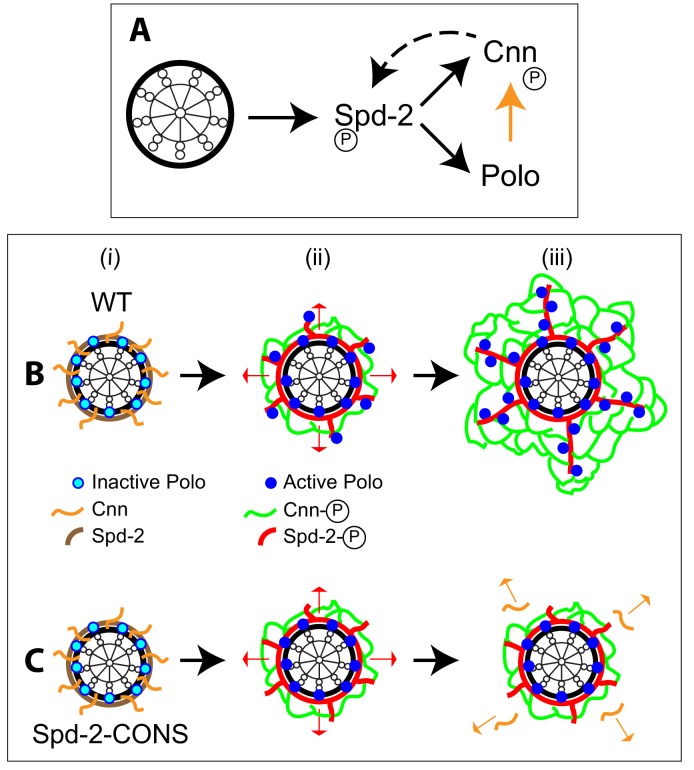
Spd-2, Polo and Cnn appear to form a positive feedback loop that drives the expansion of the mitotic PCM scaffold.(A) A schematic summary of the proposed positive feedback loop that drives the expansion of the mitotic PCM scaffold in Drosophila embryos. Solid black lines indicate recruitment, solid orange line indicates phosphorylation, dashed line indicates that Cnn does not recruit Spd-2, but rather helps to stabilise the Spd-2 scaffold that has been recruited to the mother centriole and is fluxing outwards. Polo may phosphorylate Spd-2 to create additional S-S/T(p) motifs that can then recruit more Polo, but this is not depicted here. This circuit is a classical positive feedback loop; ultimately, however, it relies on the mother centriole as a source of Spd-2, because Cnn itself cannot recruit more Spd-2 or Polo into the scaffold. (B,C) Schematics illustrate the process of centrosome maturation in a WT cell (B), and a cell in which Spd-2 cannot recruit Polo (C). During interphase (i), Spd-2, Polo and Cnn are all recruited to the mother centriole. Polo is inactive, Spd-2 and Cnn are not phosphorylated, so no scaffold forms. As cells prepare to enter mitosis (ii), Polo is activated, and the centrosomal Spd-2 and Cnn are phosphorylated, allowing them to initially assemble into a ‘mini-scaffold’ around the mother centriole. The phosphorylated Spd-2 scaffold then starts to flux away from the mother centriole (red arrows). In normal cells (B[iii]), the expanding Spd-2 scaffold recruits more Cnn and more Polo, allowing more Cnn scaffold to assemble. The Cnn scaffold cannot recruit more Spd-2 or Polo, but it stabilises the expanding Spd-2 scaffold; this allows the Spd-2 scaffold to accumulate around the mother centriole. This creates a positive feedback loop that drives an increasing rate of expansion of the Spd-2 and Cnn scaffolds around the mother centriole. If the expanding Spd-2 scaffold cannot recruit Polo (C[iii]), the Cnn recruited to the expanding Spd-2 scaffold is too far away from the centriole to get phosphorylated by Polo so it cannot form a scaffold and rapidly dissipates into the cytosol (orange arrows). The positive feedback loop is broken, and centrosome maturation fails.